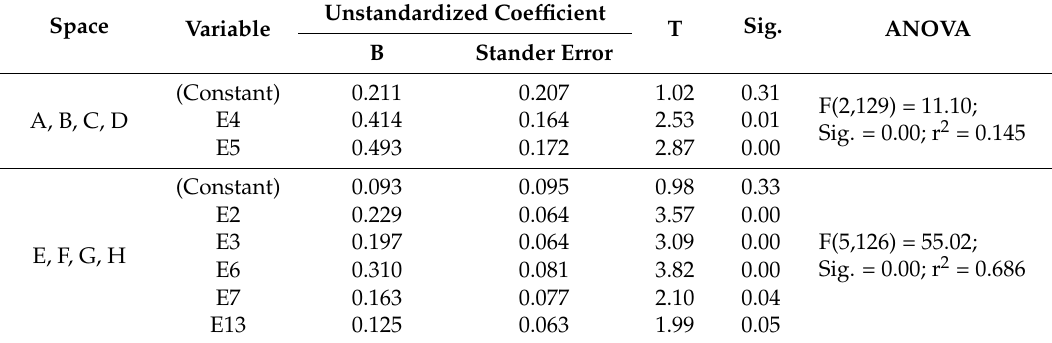
Table 8. Relationship between spatial factors and occupants’ perception of